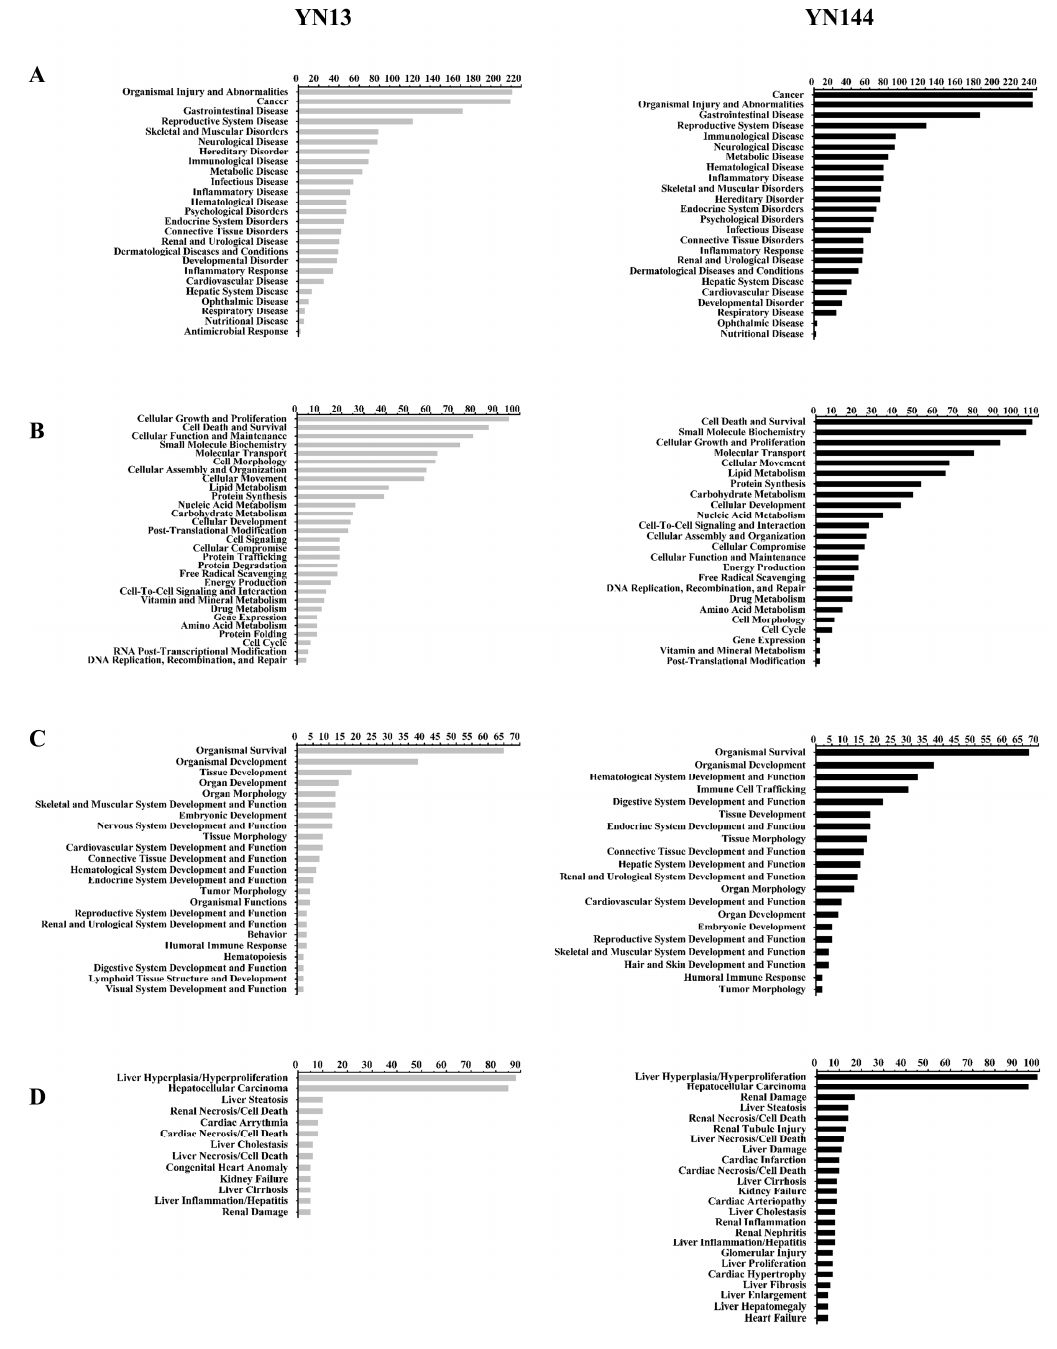
Figure 3. Functional characterization of significantly differently expressed proteins of YN13 and YN144-infected groups. ( A ) Diseases and disorders; ( B ) Molecular and cellular functions; ( C ) Physiological system development and functions; ( D ) Toxicity functions. More information is available in the Supplementary Materials File S3.